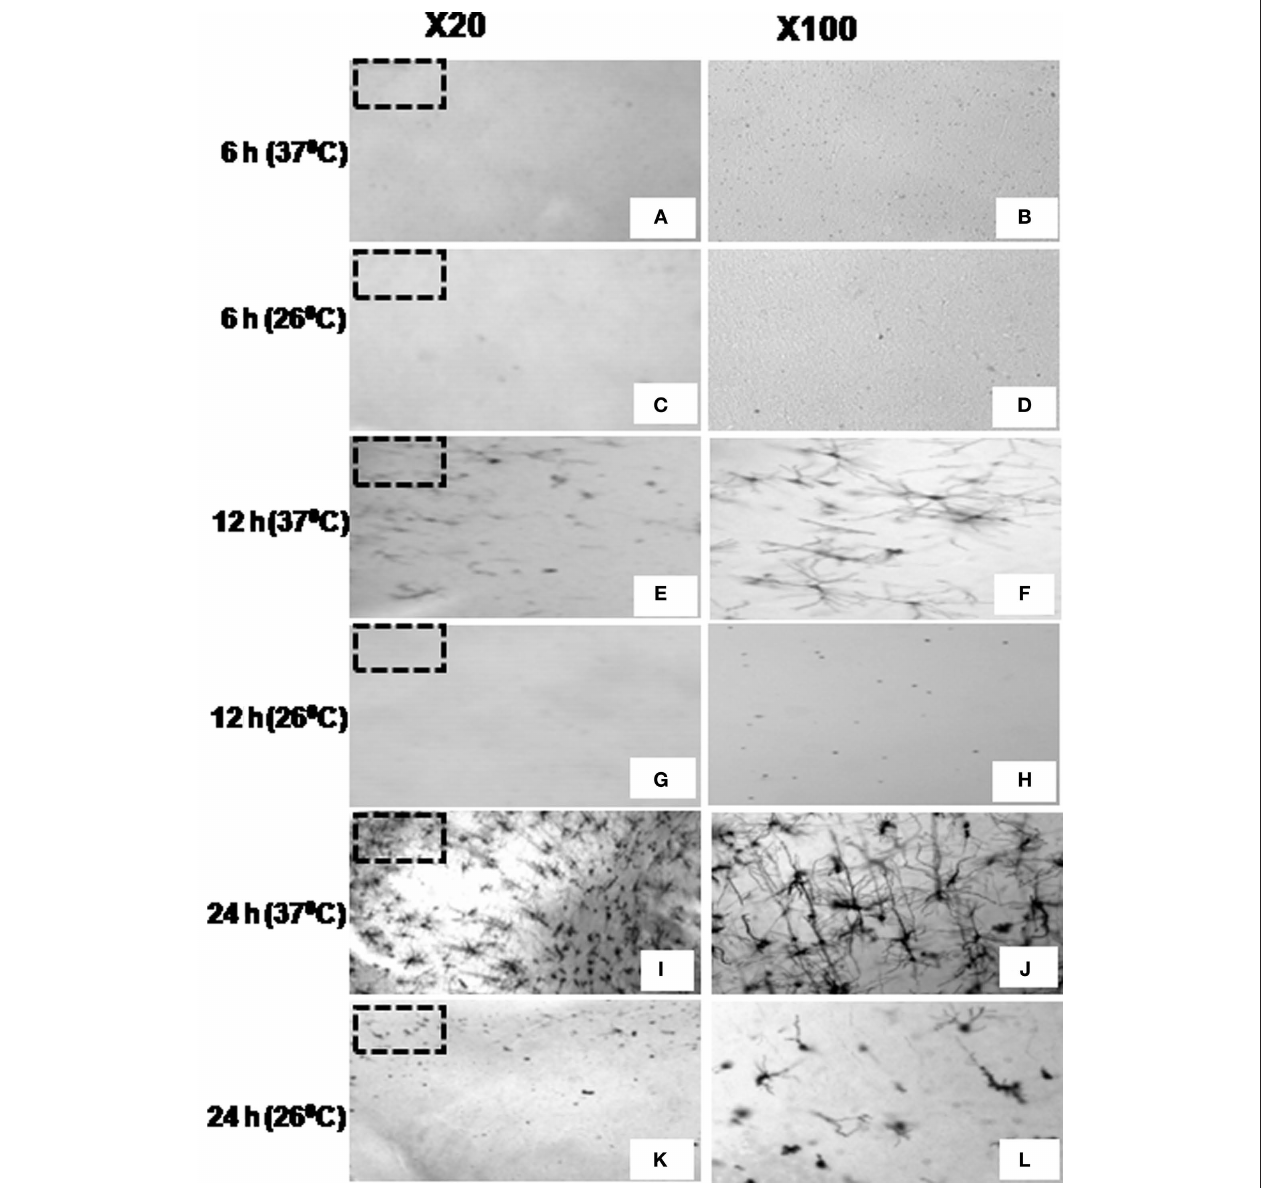
FIGure 4 | Stained neurons in cortical sections at × 20 (left panel) and × 100 (right panel, magnified view of the marked area on × 20) prepared from brain blocks incubated in Golgi–Cox solution for 6 h (A–D), 12 h (e–H), or 24 h (I–L) at 37 ± 1 ° C (A,B,e,F,I,J) or at 26 ± 1 ° C (C,D,G,H,K,L) showing temperature and duration of incubation are critical for